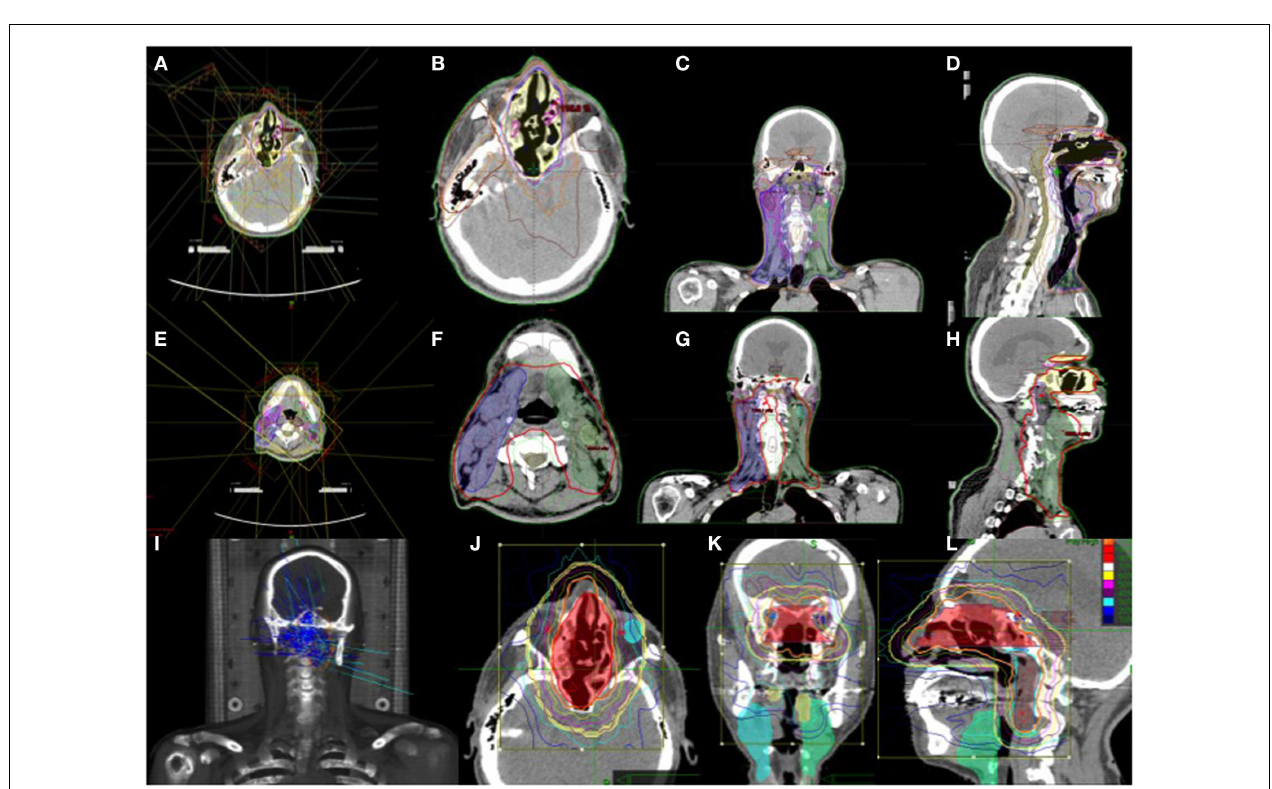
FIGURE 6 | (A–H) IMRT treatment plan with contoured target volume in axial, coronal, and sagittal view for the nasopharyngeal volume (A–D) and the neck volumes (E–H). (I–L) Cyberknife treatment plan with the target volume in axial, coronal, and sagittal views.